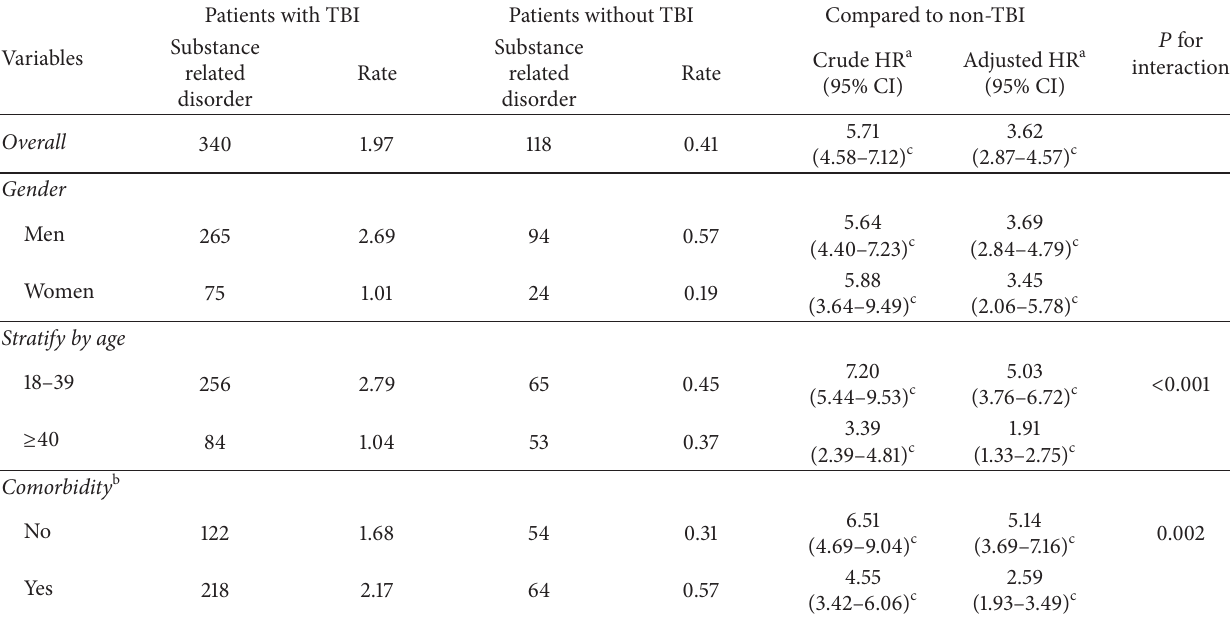
Table 2: Incidence and hazard ratios of substance related disorder by demographic characteristics and comorbidity among patients with or without TBI.